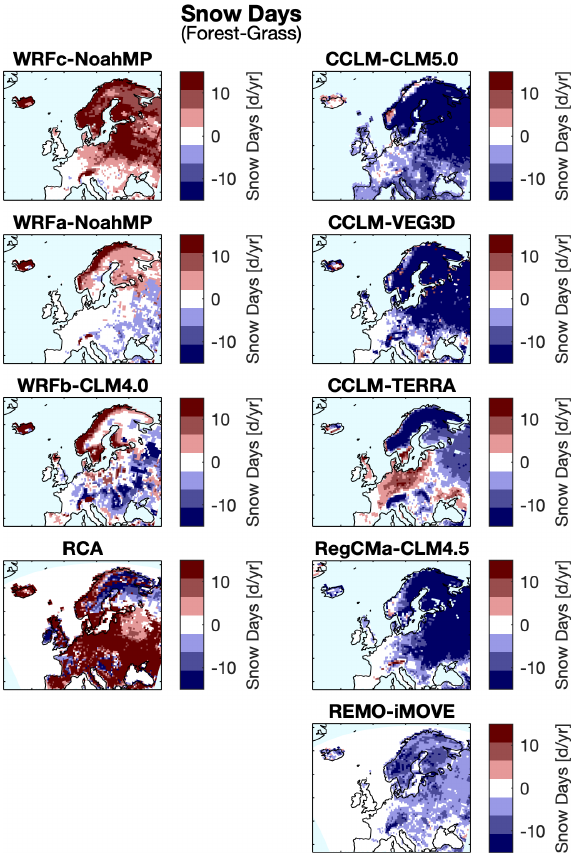
Figure 7. Impact of afforestation (FOREST – GRASS) on the start of the snowmelt season in the three different regions shown in Fig. 1. The snowmelt season starts when the 5d moving mean of snow water equivalent reaches 80% of the maximum value of the 5d moving mean in the